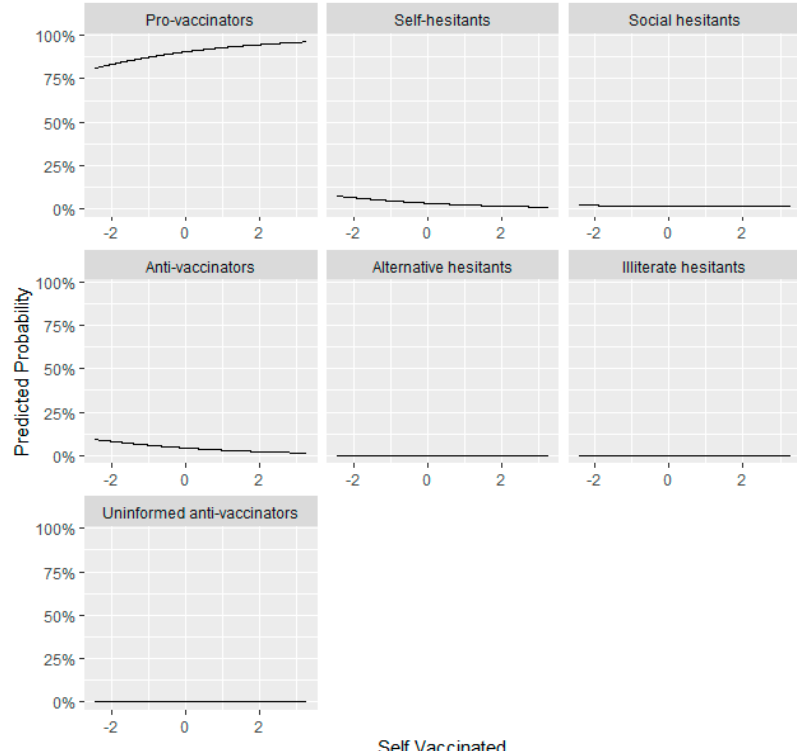
Figure A8. Marginal Effects Multinomial Logistic Regression. Self